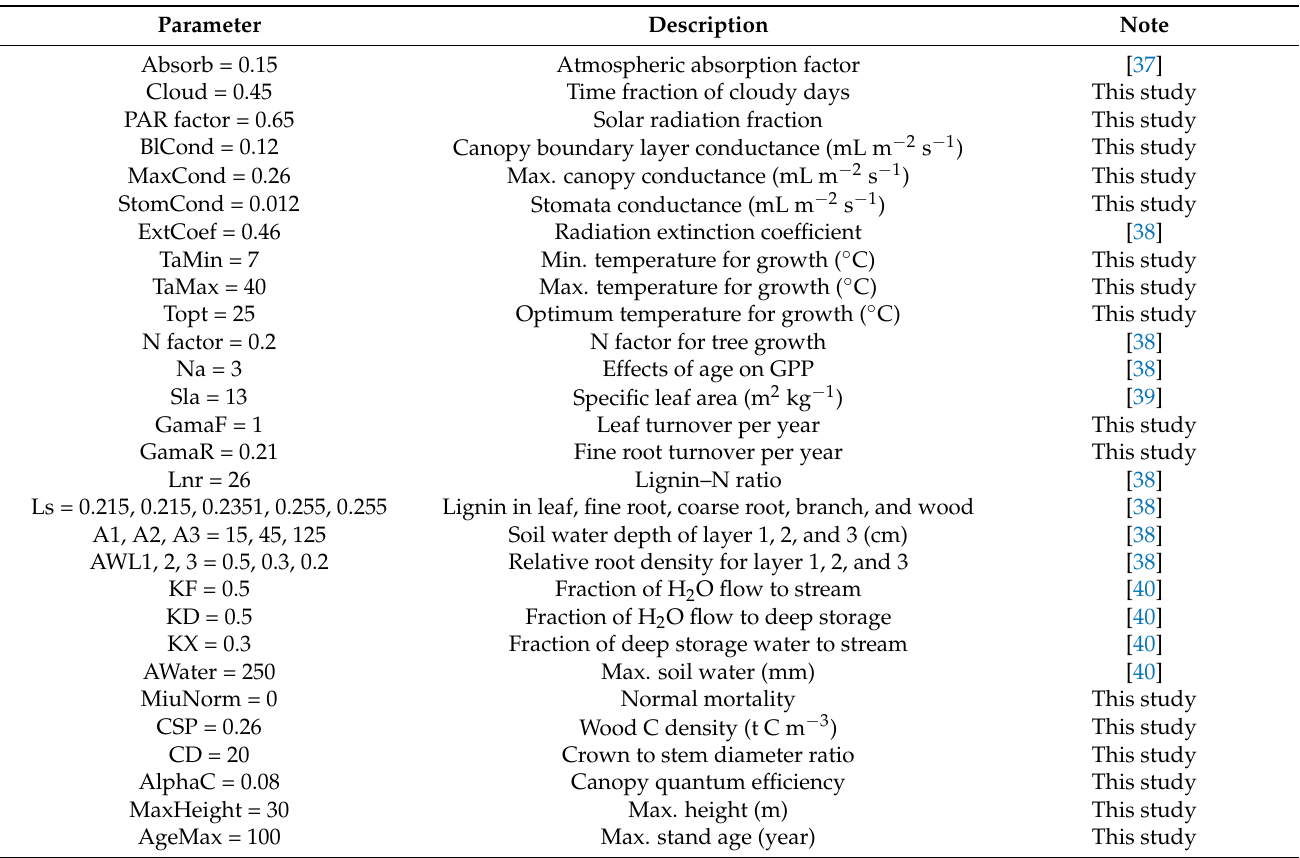
Table 2. Parameters used within the model